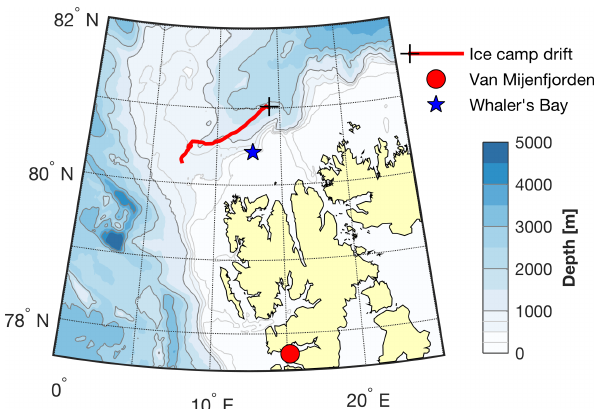
Figure 1. Overview of the study region north of Svalbard, showing the drift track of the ice camp studied here, with its starting point marked by a cross. The positions of the Van Mijenfjorden study (Widell et al., 2006) and Whaler’s Bay (Sirevaag, 2009) are shown for